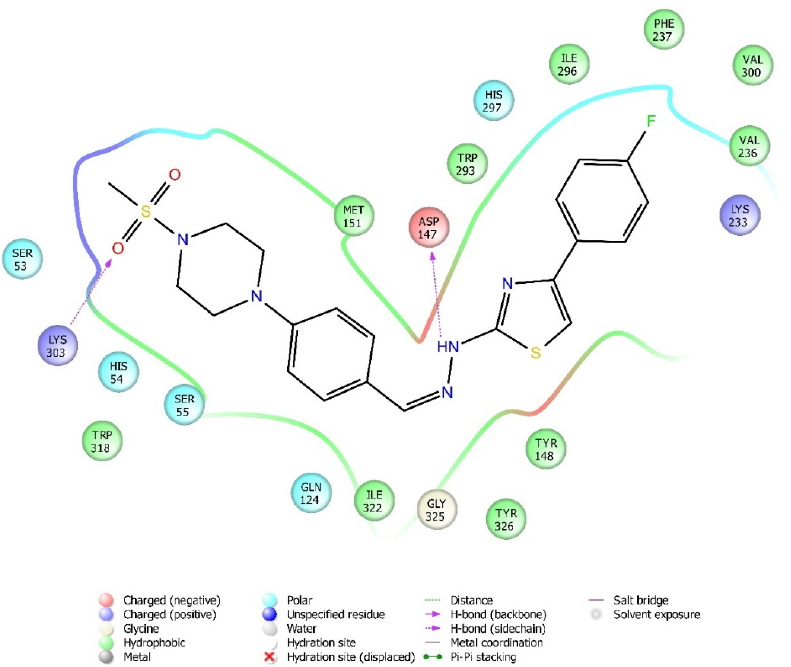
Figure 11. The two-dimensional interacting mode of compound 3f in the active region of µ-opioid receptor (PDB Code: 5C1M).